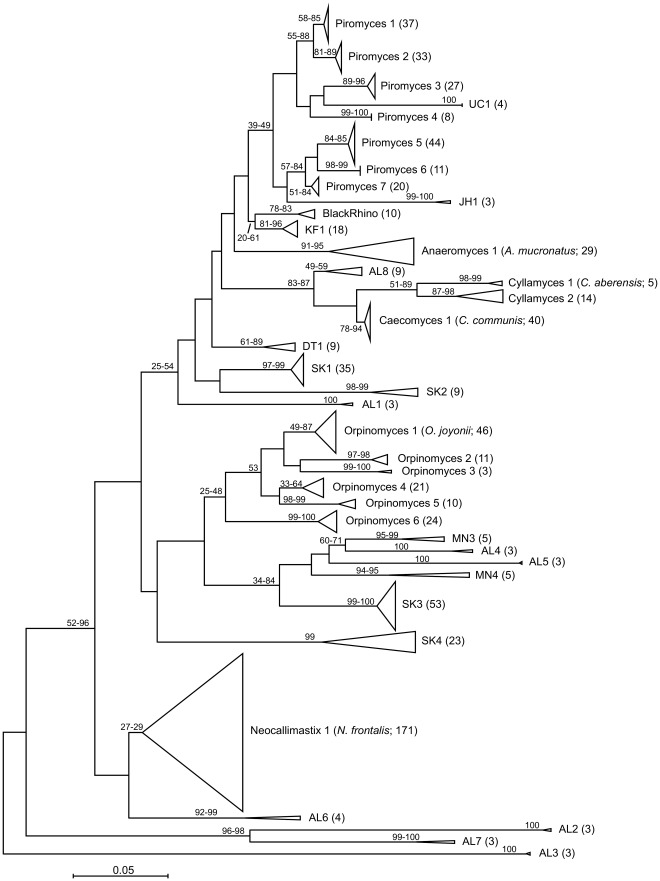
Proposed working taxonomy of the anaerobic fungi based on ITS1 genes.Phylogenetic tree constructed from 759 fungal ITS1 gene sequences (positions 105 to 372; numbering after Tuckwell et al.
[25]) using the Neighbor-Joining (NJ) algorithm with pairwise deletion and Jukes-Cantor (JC) correction [37]. In total, four different trees were calculated in MEGA5 with two different treeing algorithms and two different correction models (NJ-JC, NJ-Kimura, UPGMA-JC, and UPGMA-Kimura), and values on branches indicate the range of bootstraps obtained across the 4 trees (from a total of 1,000 replicates for each tree). Bootstraps are not shown if branching was unstable or values <20. The scale bar indicates 0.05 nucleotide substitutions per nucleotide position. For clarity, coherent groups are collapsed into triangles, with the number of sequences shown in parentheses after the group designation and the corresponding type species (if available). Assignment of individual sequences to the corresponding clusters can be deduced from the taxonomy file available from the authors upon request. The following cluster designations differ from previous naming schemes (former name and literature reference are given in brackets): AL1-8 (NG1-8; [21]), MN3-4 (NG3-4; [22]), Cyllamyces 1–2 (NG1 Cyllamyces; [22]), Orpinomyces 1–6 (Orpinomyces/Piromyces II; [25]), Piromyces 1–7 (Piromyces III; [25]).